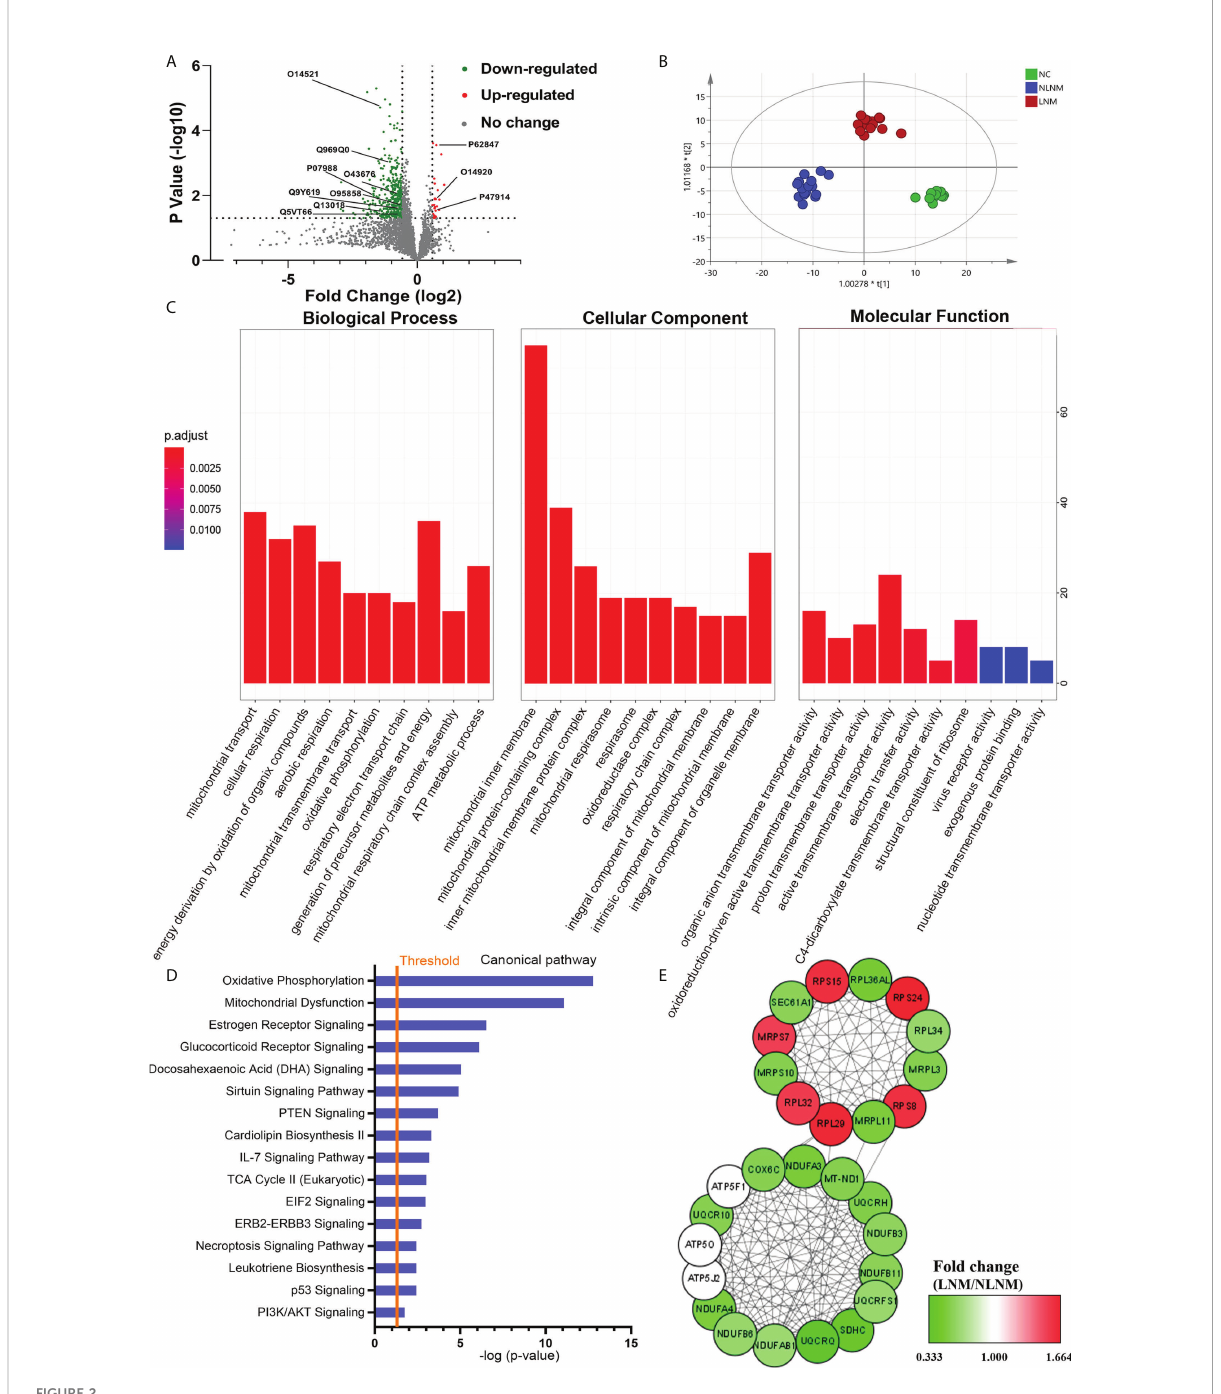
FIGURE 2 Comparative analysis of proteome expression pro fi les between the LNM and NLNM groups. (A) Scatter plot showing the distribution of downregulated (green dots) and upregulated (red dots) differentially expressed proteins (DEPs) between the LNM and NLNM groups. (B) Orthogonal partial least squares discriminant analysis revealed differences in the proteome pro fi les among the LNM, NLNM, and normal control (NC) groups. “ LNM ” refers to PTMC with lymph node metastasis, “ NLNM ” refers to PTMC without lymph node metastasis, and “ NC ” refers to peritumoral tissues. (C) Gene Ontology enrichment analysis of DEPs between the LNM and NLNM groups. The categories of biological process (BP), cellular component (CC) and molecular function (MF) are respectively shown. (D) Annotation and functional characterization of DEPs. (E) Protein-protein interaction (PPI) network analysis of DEPs between the LNM and NLNM